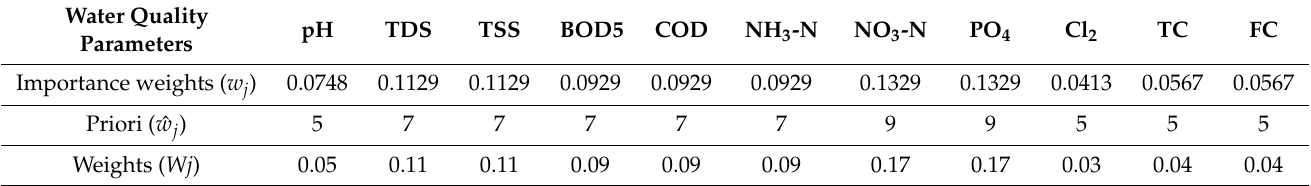
Table A3. Weights estimation